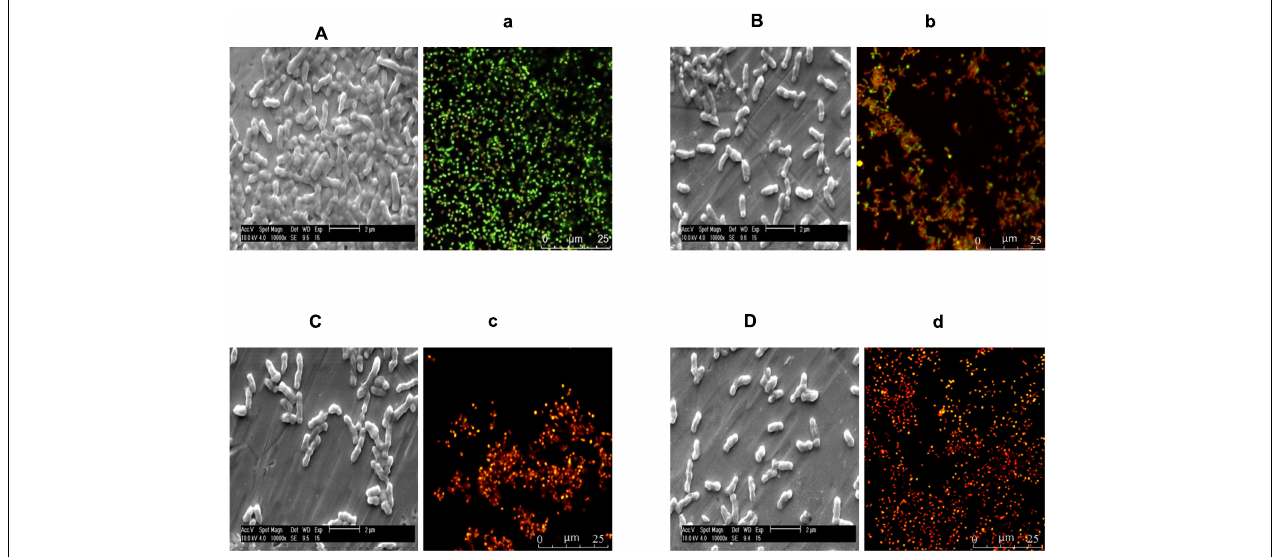
FIGURE 4 | Environmental scanning electron microscopy (ESEM) and confocal laser scanning micrographs (CLSM) of Campylobacter jejuni NCTC 11168 biofilm before treatment with phytochemicals (controls; A,a ) and after treatment with 18.91 mM of trans -cinnamaldehyde (B,b) , 15.22 mM eugenol (C,c) , or 16.64 mM carvacrol (D,d) . C. jejuni (6 Log CFU) was inoculated on stainless-steel coupons and Lab-Tek two-chamber (no. 1) borosilicate coverglass system for ESEM and CLSM, respectively, to develop biofilms at 37 ◦ C for 2 days. The biofilms were exposed to phytochemicals for 10 min followed by gentle washing. For the ESEM (A–D) , the treated biofilms were fixed with 2.5% glutaraldehyde and dehydrated in a series of ethanol concentration (30–100%). Dried biofilms were coated with gold using Emitech SC7620 sputter coater and visualized using 10 kV beam in ESEM. For the CLSM (a–d) , the treated biofilms were stained with 0.01 mM SYTO